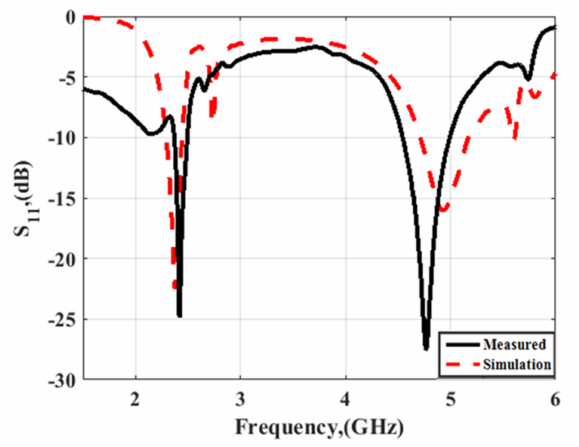
Figure 14. S 11 results of the proposed antenna integrated with